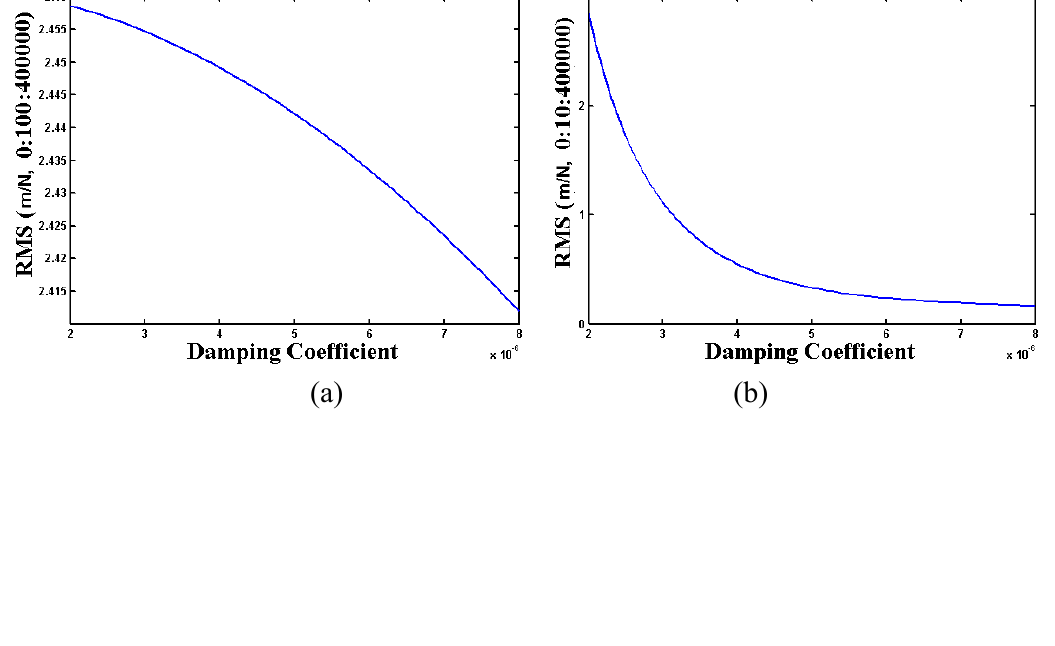
Figure 15. Comparison of RMS and Q